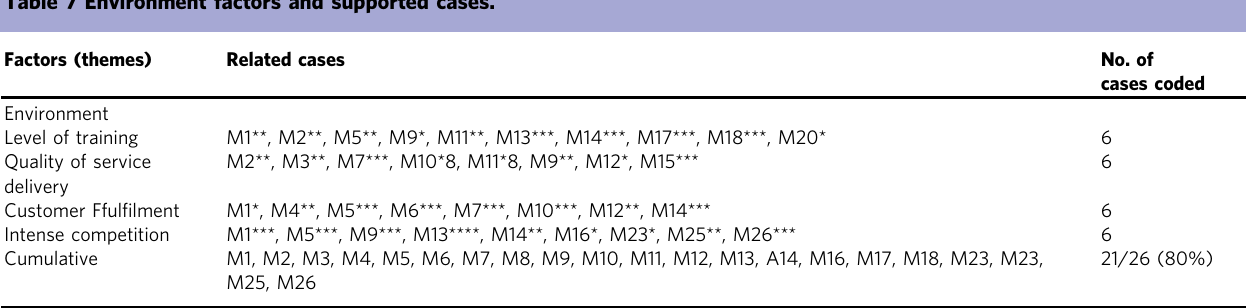
Table 7 Environment factors and supported cases.